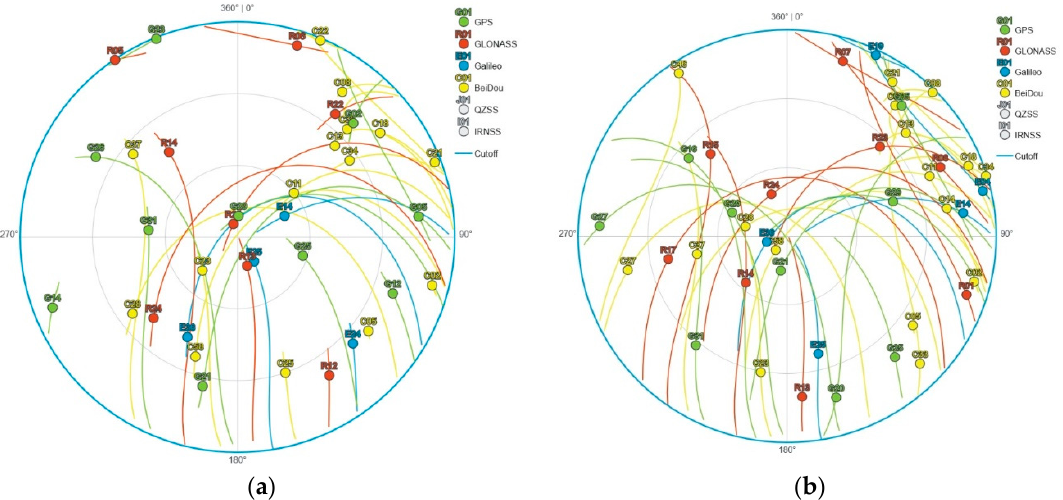
Figure 7. Skyplot of visible satellites for 16 July 2019: ( a ) at the beginning of the experiment 08:20:00 UTC and ( b ) at the end of the experiment 09:58:00 UTC [48].